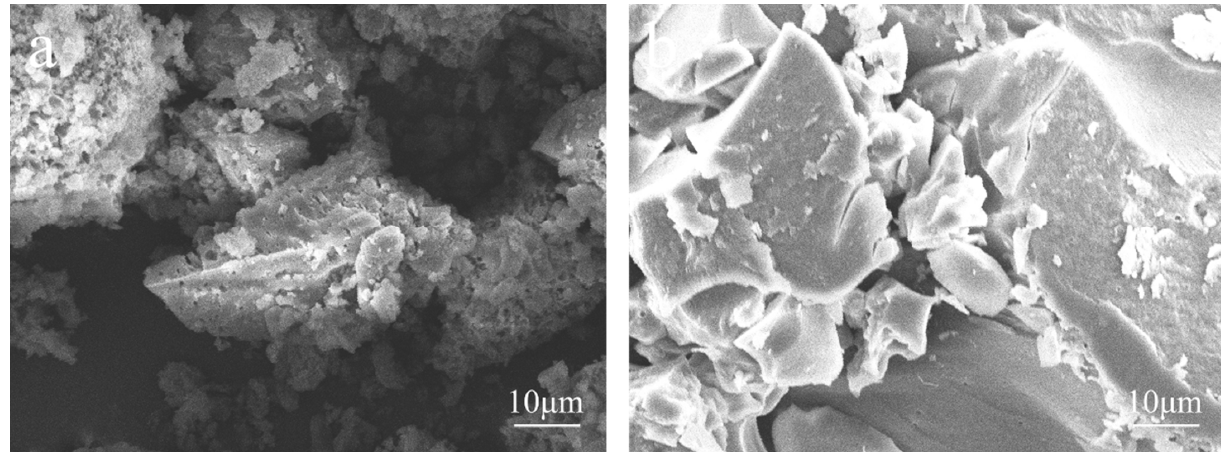
Figure 1. SEM images of ( a ) EHL and ( b ) HEHL at ×2000 magnification.